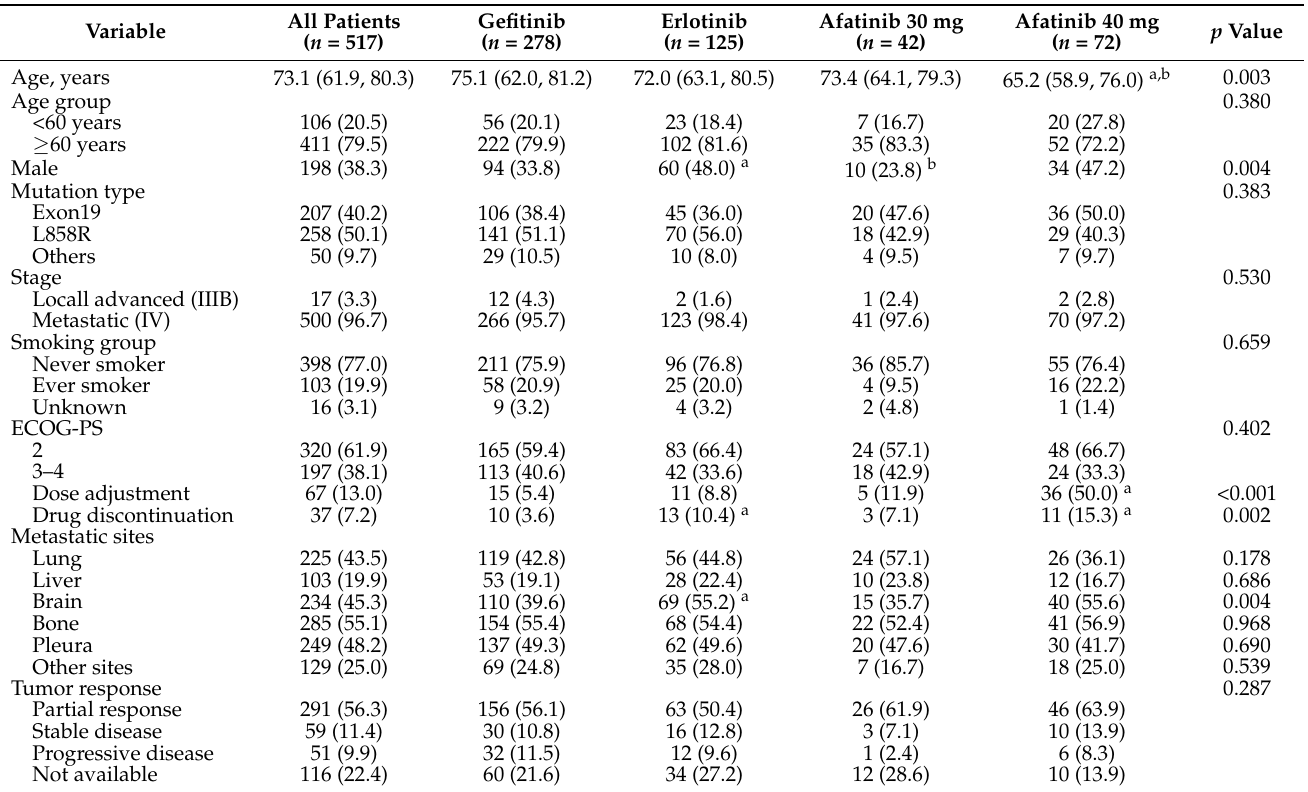
Table 1. Baseline